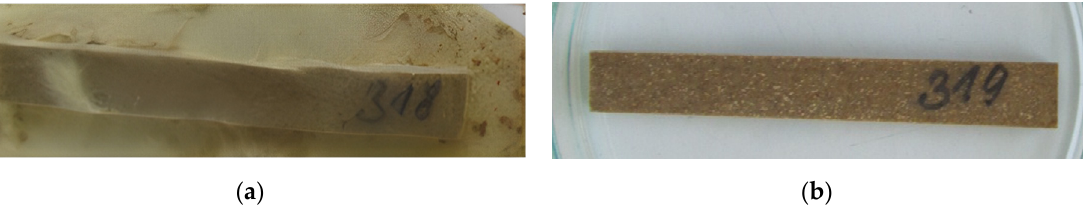
Figure 1. Oat husk-reinforced composite specimens after ( a ) exposure to Coniophora puteana ; ( b ) mycelium removal.